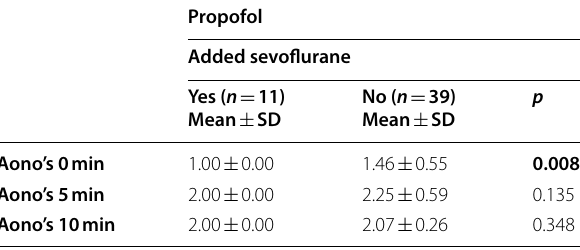
Table 7 Comparison of Aono’s values in propofol groups with added